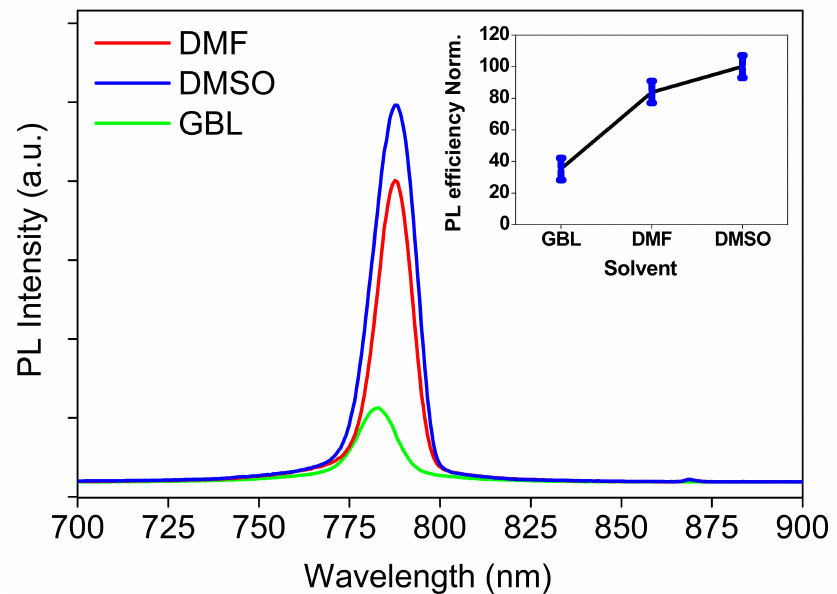
Figure 6. PL spectra of the MAPbI 3 perovskite thin films prepared using different solvents, for 532 nm as excitation wavelength for all samples. The insets show normalized PL efficiencies with statistical distribution (error bar) of the prepared films for three